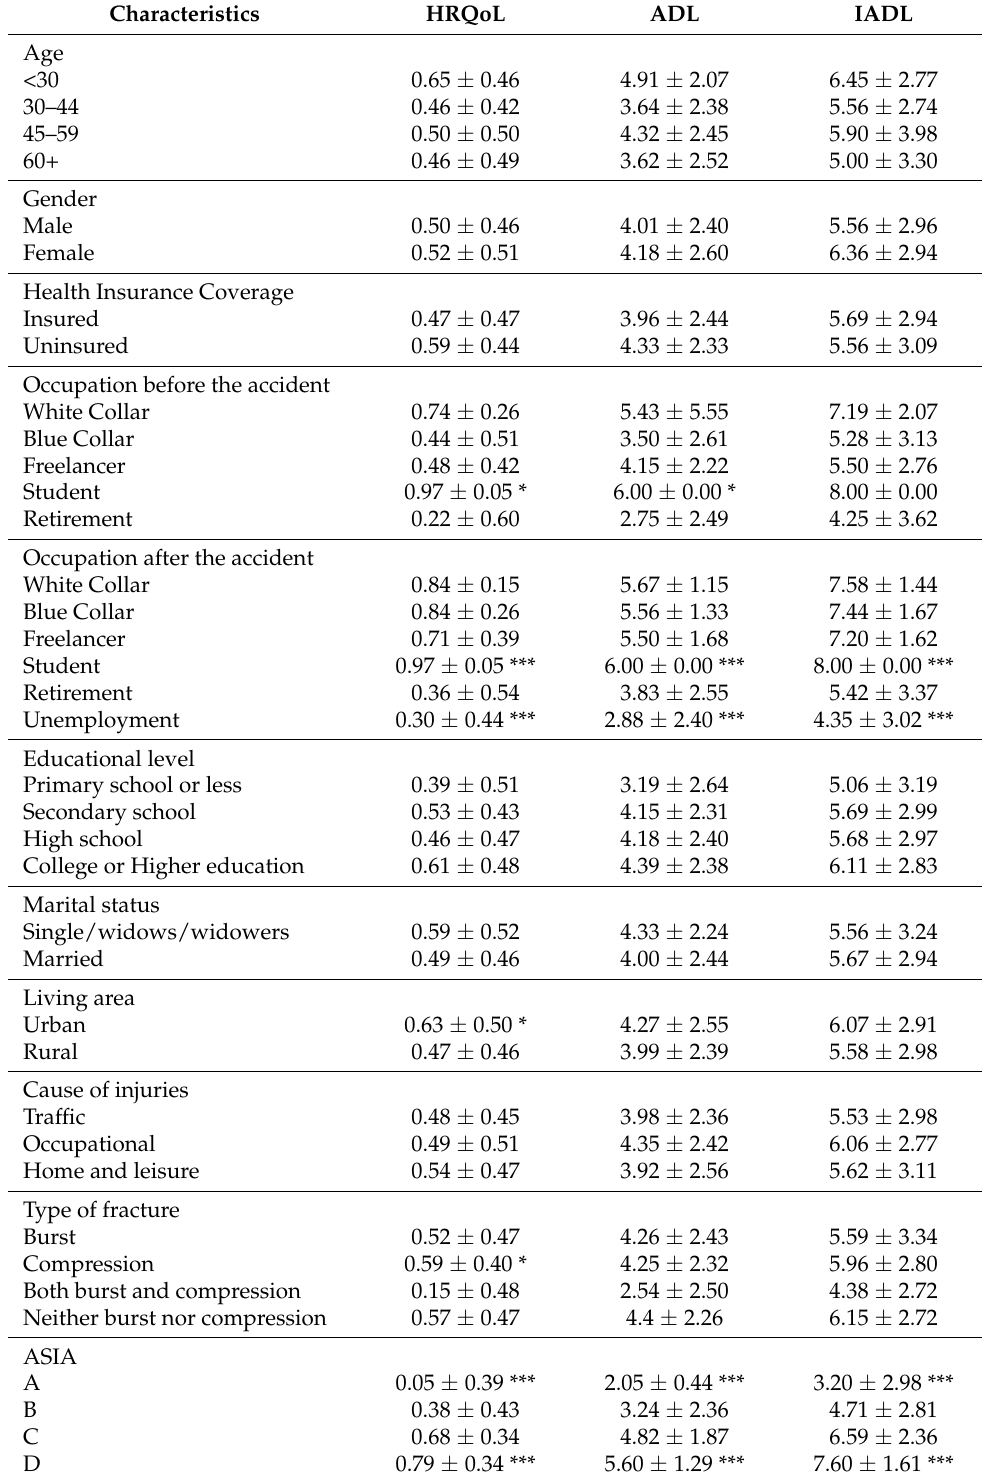
Table 2. The mean and standard deviation of the HRQoL, ADL, IADL index by patients’